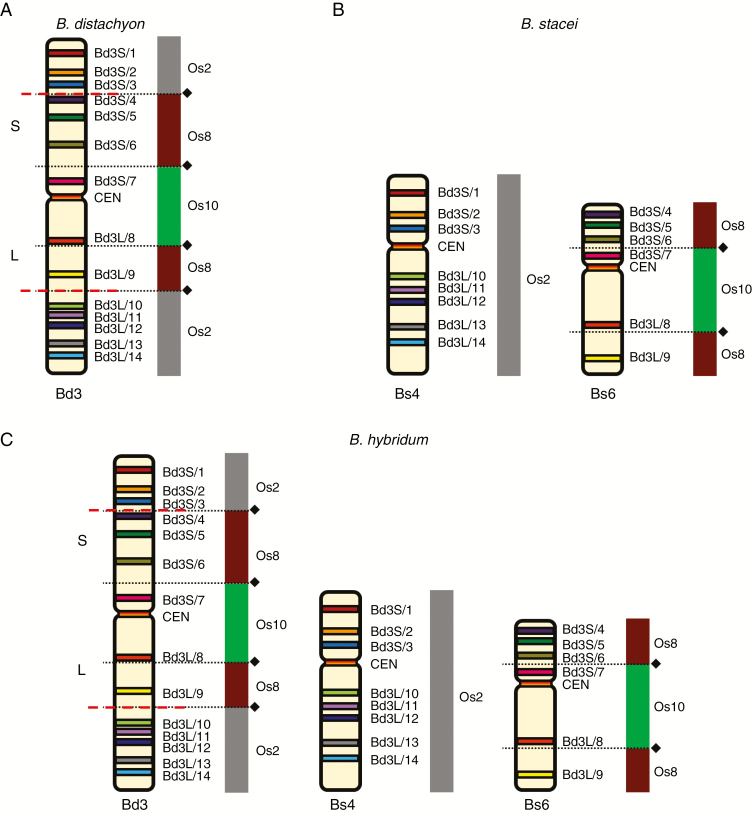
Chromosomal distribution of the BAC clones that were derived from chromosome Bd3 of B. distachyon (A) and comparatively mapped to the chromosomes of B. stacei (B) and B. hybridum (C). The distribution of the clones on the chromosome diagram (A) reflects their position on the physical map of the B. distachyon genome (Febrer et al., 2010). The diagrams next to the Brachypodium chromosomes relate the BAC clones to the homoeologous regions in different rice chromosome equivalents. Black diamonds and dotted lines indicate the hypothetical fusion points of the intermediate ancestral grass chromosomes in Bd3 (adapted from IBI, 2010). Red dashed lines indicate the chromosomal breakpoints that were found in the Bs-genome chromosomes in B. stacei and B. hybridum.